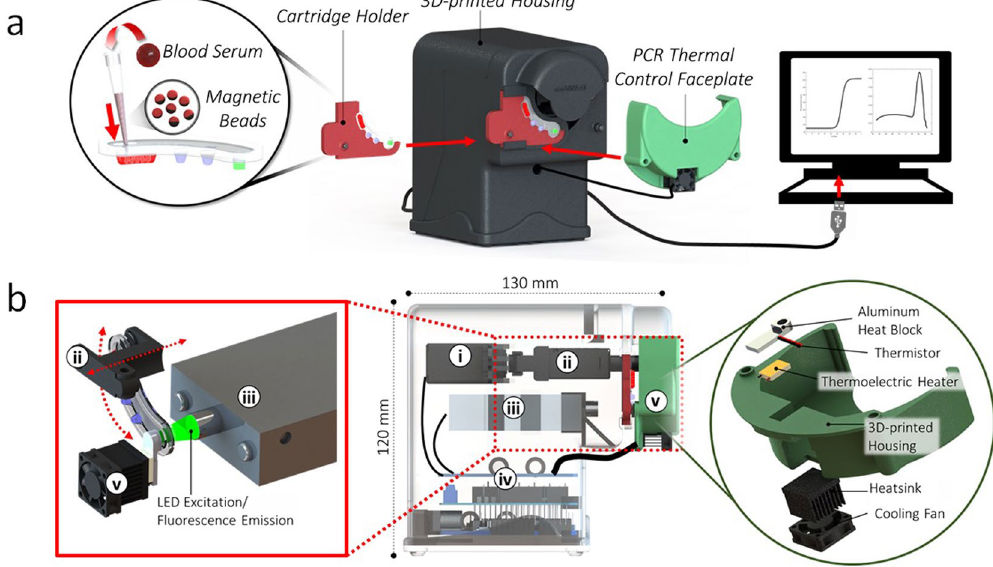
Figure 1. Device operation and instrumentation ( a ) the complete user-operation steps are illustrated here from left to right including injection of serum with magnetic particles into the cartridge, cartridge mounting in a holder with insertion into the instrument, assembly of the faceplate onto the cartridge for thermal cycling, and USB readout of PCR results. ( b ) A profile view of the instrument with ghosted housing reveals internal components including (i) rotational servo and (ii) linear servo for magnetic particle transferal between cartridge wells and in/out of reagent droplets respectively, (iii) confocal epifluorescence detector for PCR fluorescence acquisition, (iv) microcontroller electronics for integrated control of magnetic manipulation, algorithmic heating, triggering fluorescence detection, and serial communication for data storage and analysis, (v) PCR thermal control faceplate with a fan-cooled heatsinked thermoelectric heating element attached to an aluminum heat block that fits over the cartridge PCR well with an embedded thermistor probe for monitoring